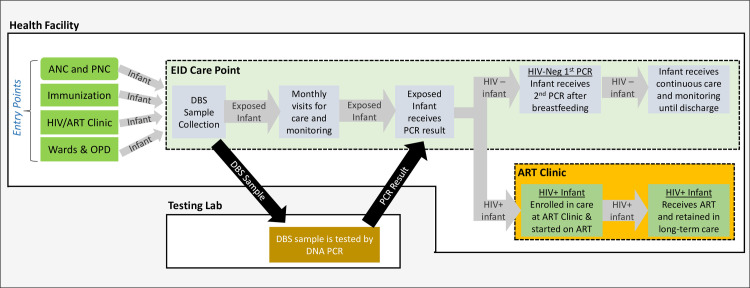
Uganda’s EID cascade.Diagram showing key steps in the HIV Early Infant Diagnosis process in Uganda. Each step represents a potential loss point for HIV-exposed and/or HIV-positive infants. ANC = Antenatal Care Clinic, PNC = Postnatal Care Clinic, OPD = Outpatient Department, DBS = Dried Blood Spot, PCR = Polymerase Chain Reaction.